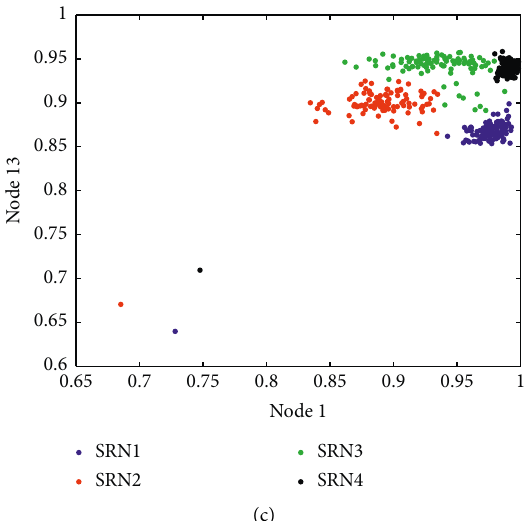
Figure 6: Feature distribution of the optimal result of dual feature recognition for four types of SRN. (a) HDE. (b) HRDE. (c)